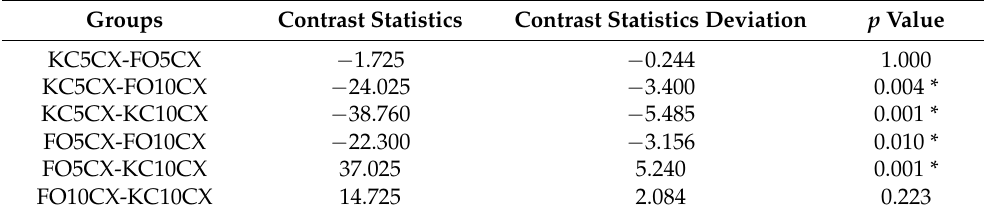
Table 2. Comparison between experimental